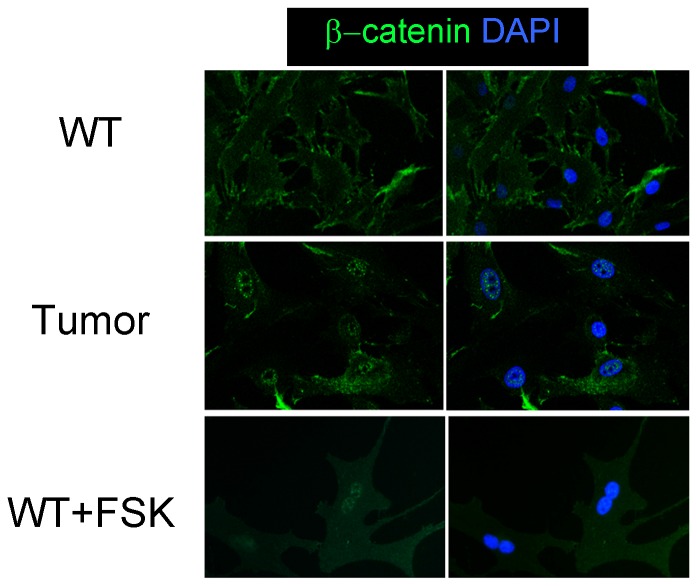
β-catenin forms punctate nuclear lesions in response to PKA activation in primary cultures.Primary osteoblasts from wild type (WT) bones or from bone tumors arising in Prkar1a+/− mice were studied by immunofluorescence for β-catenin (green). For reference, cell nuclei were stained with DAPI. The left column shows β-catenin, only, whereas the right column shows merger of the β-catenin and DAPI stains. Top) WT osteoblasts. Middle) Tumor osteoblasts. Bottom) WT osteoblasts treated with forskolin (FSK). Note the punctate nuclear localization of β-catenin observed in Tumor cells or WT cells treated with FSK. Magnification: 400x.